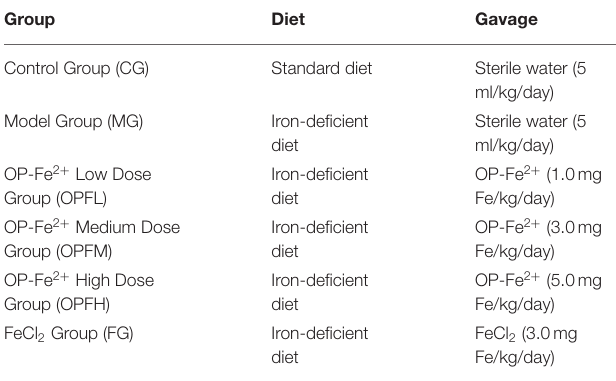
TABLE 2 | Summary of the experiment design and the doses of OP-Fe 2 + or Fecl 2 on rats. Group Diet Gavage